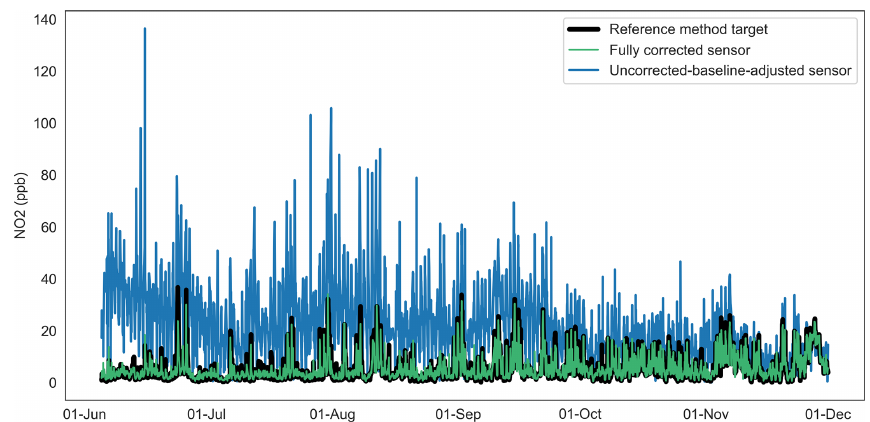
Figure 9. Time series of uncorrected-baseline-adjusted sensor, fully corrected sensor and reference method observations for NO 2 at Oxford St Ebbe’s for 2020.